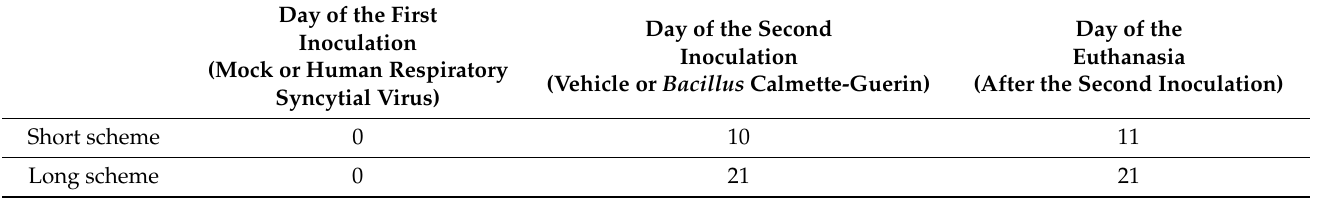
Table 1. Schemes of infection and their